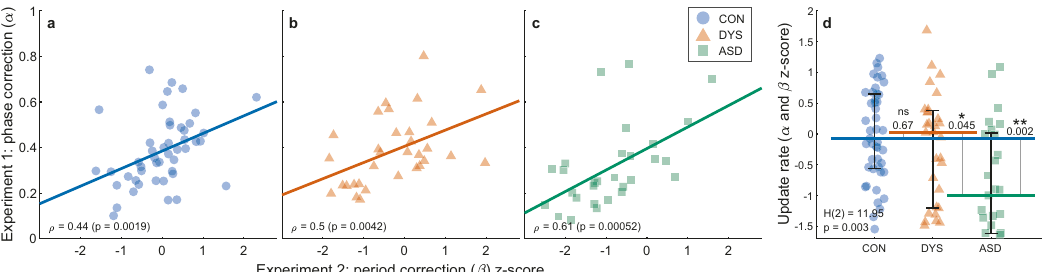
Fig. 7 Rate of online error correction in stationary and in changing environments re fl ect a single updating mechanism. The estimated phase correction from Experiment 1 and the estimated period correction from Experiment 2 are highly correlated in all groups a neurotypical (CON control), b dyslexia (DYS), c autism (ASD), suggesting that both are manifestations of a common underlying mechanism of error correction, which determines the speed of integrating new sensory data to guide behavior. The signi fi cance of Spearman correlation was calculated using a two-sided test, p values are uncorrected. Overlayed regression lines, predicting phase correction (Experiment 1) from period correction (Experiment 2) with an intercept term. d The combined update rate is signi fi cantly smaller in the ASD group but does not differ between the neurotypical and dyslexia groups. The median of each group is denoted as a line of the same color; error bars around this median denote an interquartile range. Kruskal – Wallis H -statistic and the corresponding p value are plotted in the bottom-left corner; p values of comparisons between groups are plotted next to the line connecting the groups ’ medians. N = 108 subjects ( N = 47, N = 32, N = 29), one ASD participant was excluded from the computational modeling of Experiment 1 due to a large CON DYS ASD number of missing taps (see Methods). Source data are provided as a Source Data fi le. the groups (median [interquartile range]: neurotypical: − 0.07 substantially lower updating rate yielding slower correction rates [1.21], dyslexia: 0.03 [1.57], autism: − 1 [1.63]; Kruskal – Wallis in both fi xed and changing environments. test H (2) = 11.95, p < 0.003, Fig. 7d). Post hoc comparisons revealed a signi fi cant difference between the neurotypical and Update rate is correlated with communication and mindreading ASD groups ( p < 0.002, Cliff ’ s delta = 0.45), and between dyslexia skills . Since previous literature suggests that synchronization is and ASD groups ( p = 0.045, Cliff ’ s delta = 0.35), with no associated with social skills 17,18 , we asked whether slower updating is correlated with these skills among our participants in difference between the neurotypical and dyslexia groups the neurotypical and autism groups. We administered to ( p > 0.65, Cliff ’ s delta = 0.12). Overall, the autism group had a NATURE COMMUNICATIONS| (2021) 12:5439